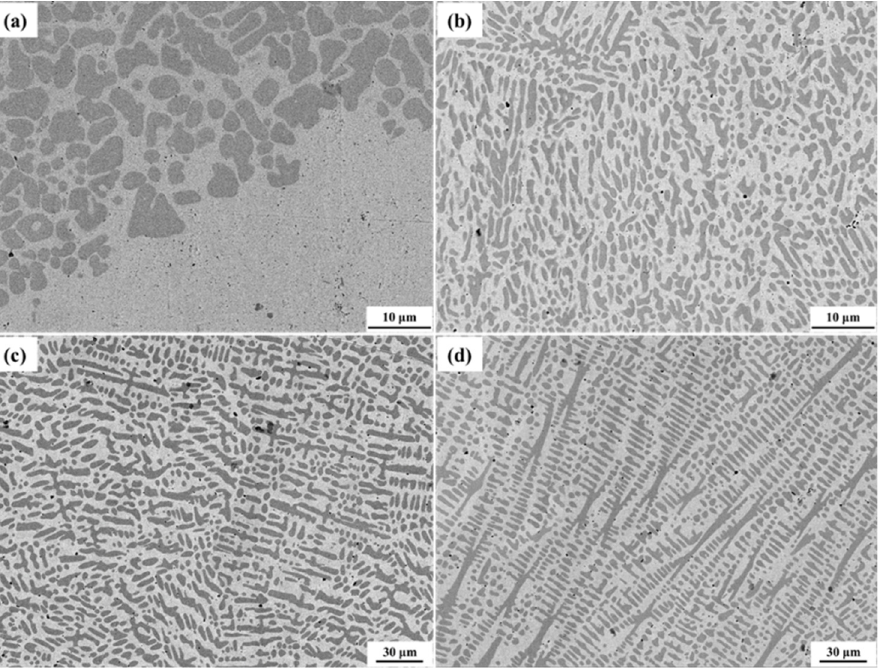
Figure 4. Microstructures of different zones of the Cu35Ni25Co25Cr15 HEA coating deposited under a welding current of 160 A: ( a ) fusion zone; ( b ) bottom zone; ( c ) middle zone; and ( d ) top zone. The microstructures of the interfacial zone of the Cu substrate and